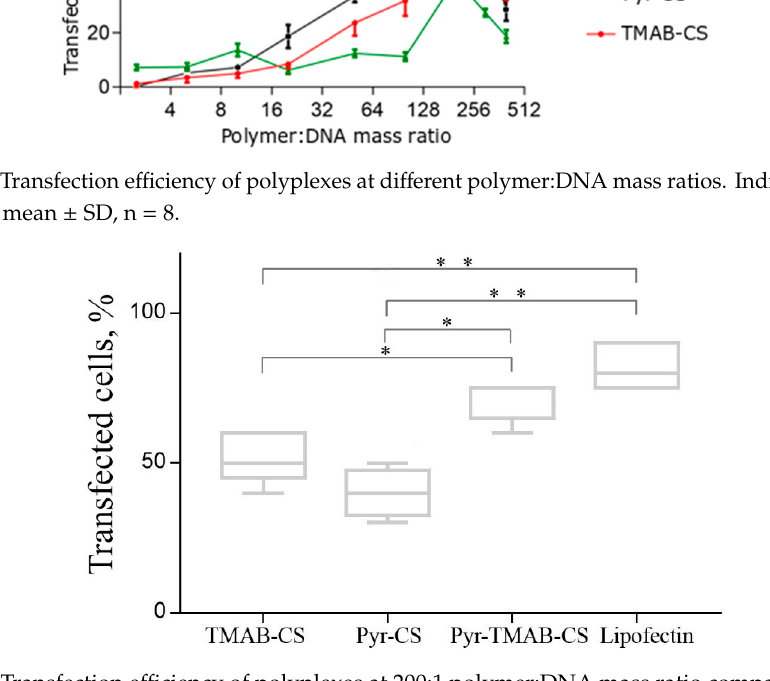
Figure 9. Transfection efficiency of polyplexes at 200:1 polymer:DNA mass ratio compared to that of Lipofectin. Each column represents the so-called “five-number summary” and describes a list of five values: the minimum, the 5th percentile, the median, the 95th percentile, and the maximum. Horizontal brackets with asterisks indicate statistically significant differences: * p < 0.01; ** p < 0.001.